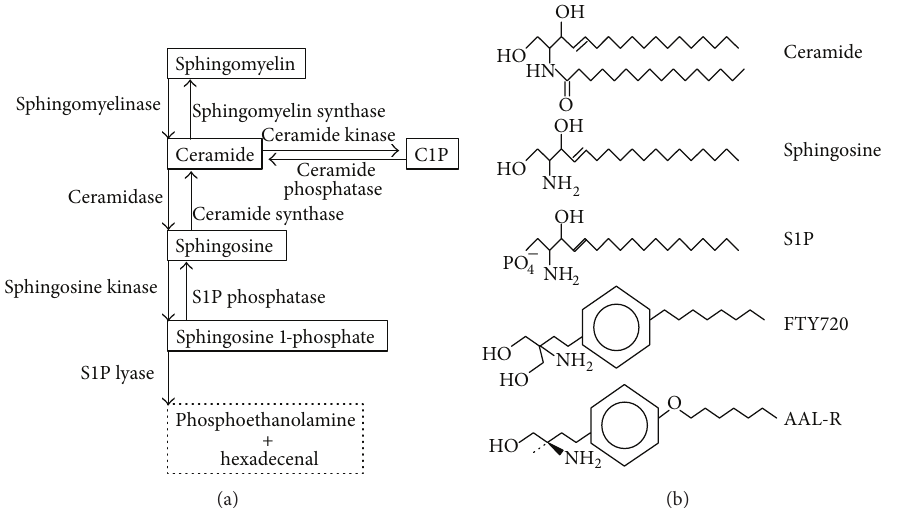
Figure 1: The sphingolipid system. (a) The pathway of sphingolipid synthesis and degradation by catalytic enzymes. (b) Shown are chemical structures of the sphingolipids (ceramide, sphingosine, and S1P) and the sphingosine analogs (FTY720 and